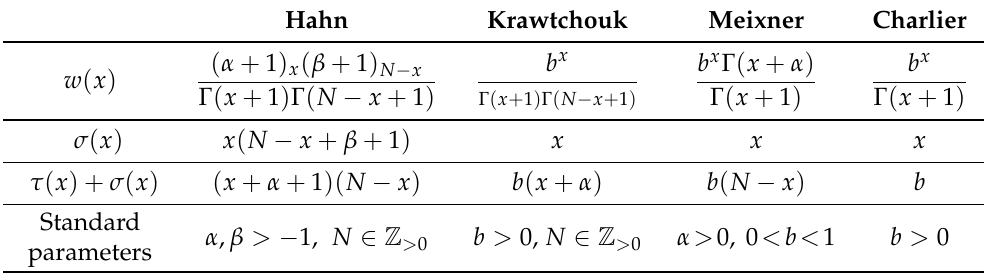
Table 2. Weights for classical orthogonal polynomials of discrete variable.